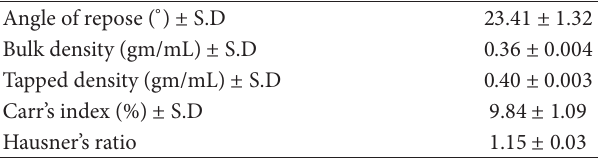
Table 2: Micromeritic properties of granules of naproxen sodium core